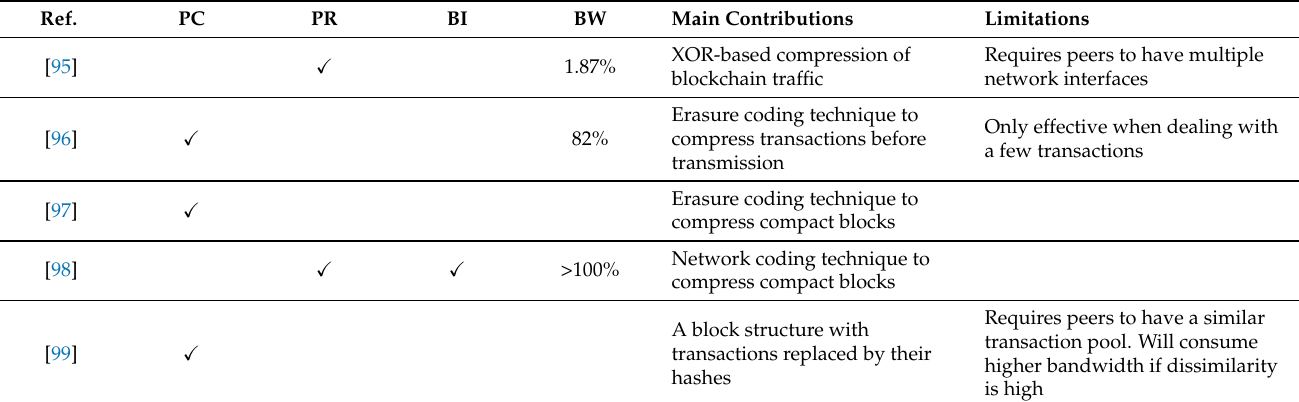
Table 8. Comparison of Data Layer Techniques. PC = Public Blockchain, PR = Private Blockchain, BI = Blockchain-IoT, BW = Bandwidth. Bandwidth = Reduction in Total Network Bandwidth due to Minimization of Duplicates or Reducing Overhead Caused by Distributed P2P Topology Management.